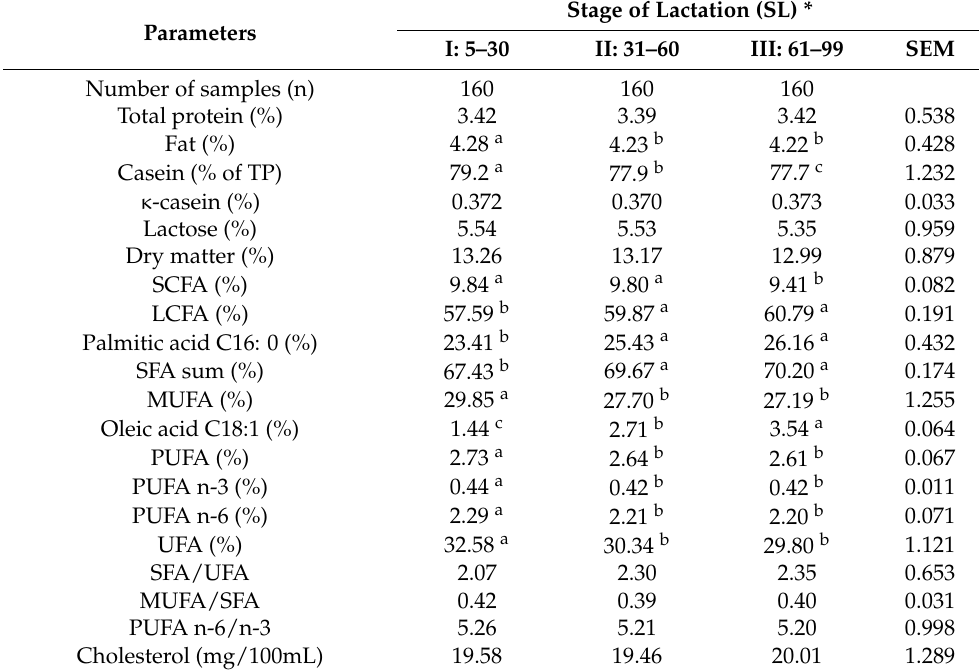
Table 5. Content of nutrients and main fatty acid fractions in milk up to 100 days of lactation.